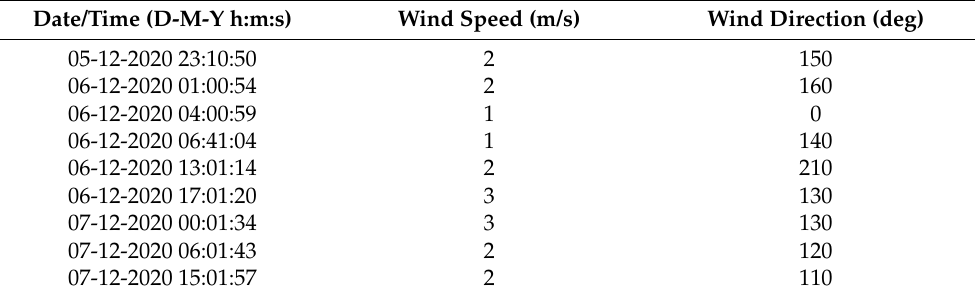
Table 2. Part of the table with data from the generated Excel